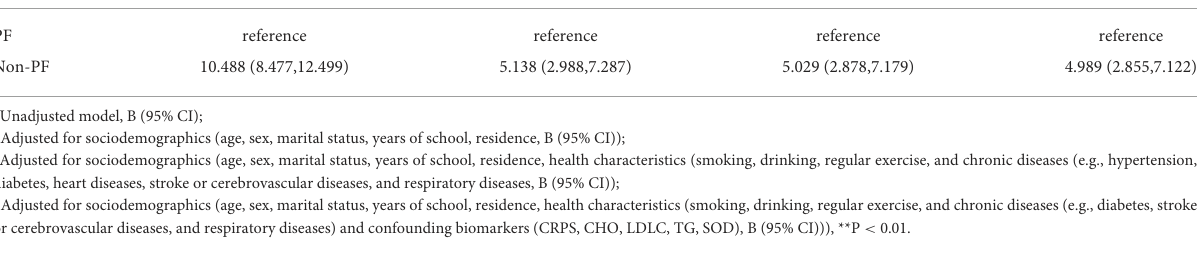
TABLE 3 The associations between physical frailty and cognitive